Question: State the chart type depicted above.
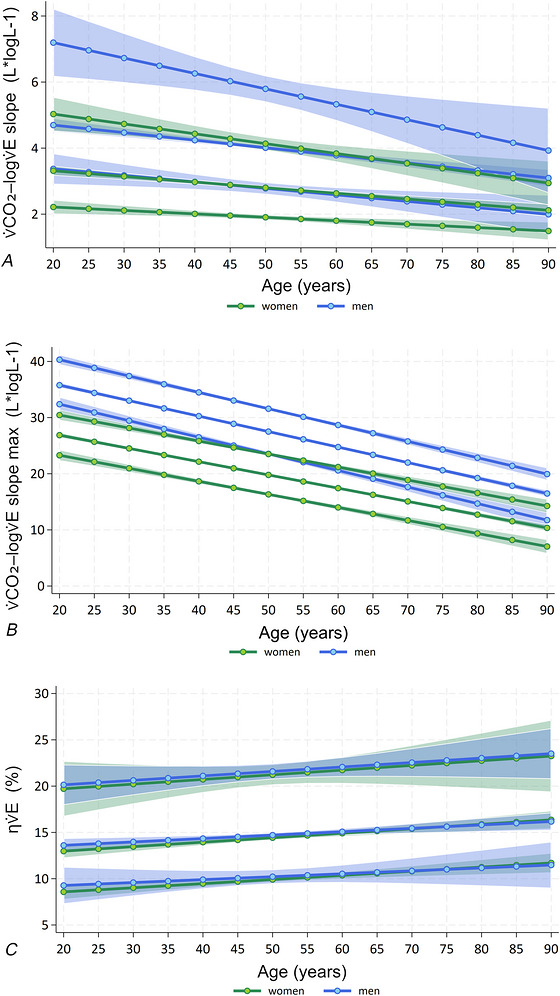
Answer: line